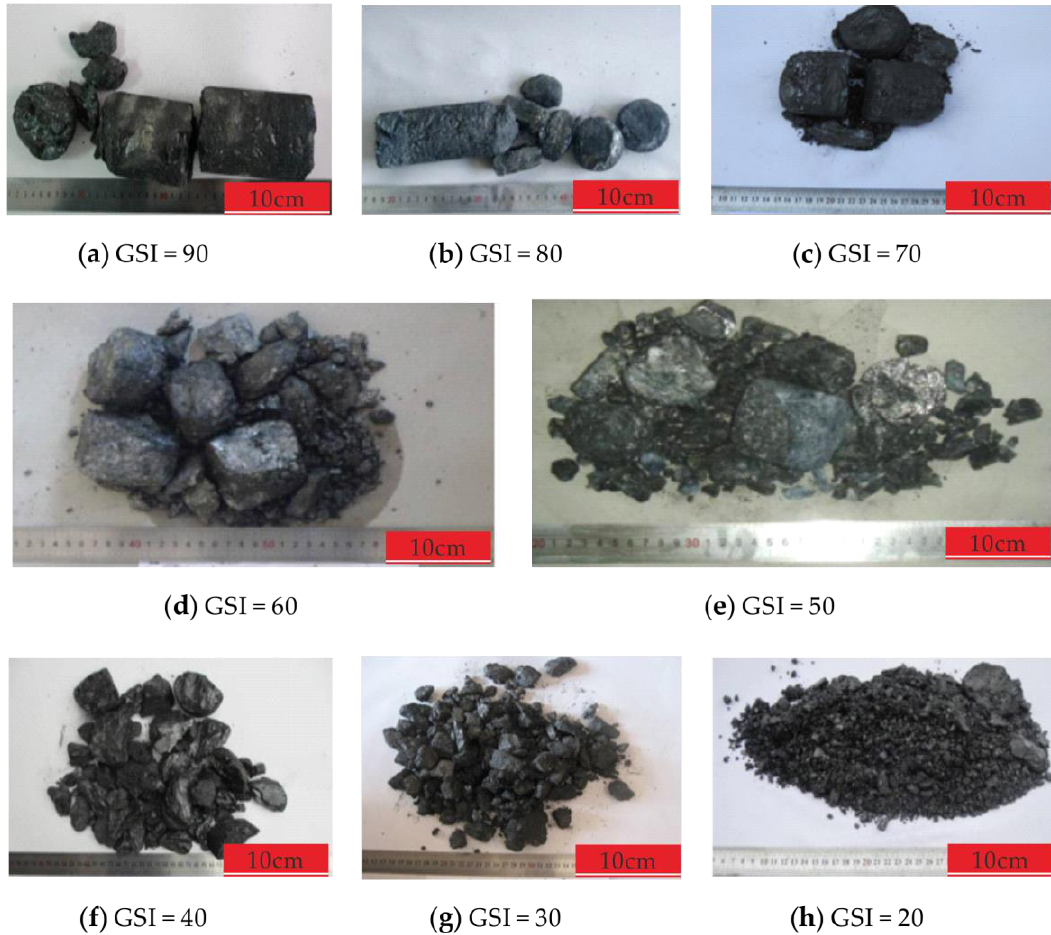
Figure 3. GSI quantisation of coal showing typical deformation in the study area. 70–100 is undeformed coal; 50–70 is cataclastic coal; 25–50 is granulated coal; 0–25 is mylonite coal. Representative coring samples were selected for observation in Shizhuangnan Block. According